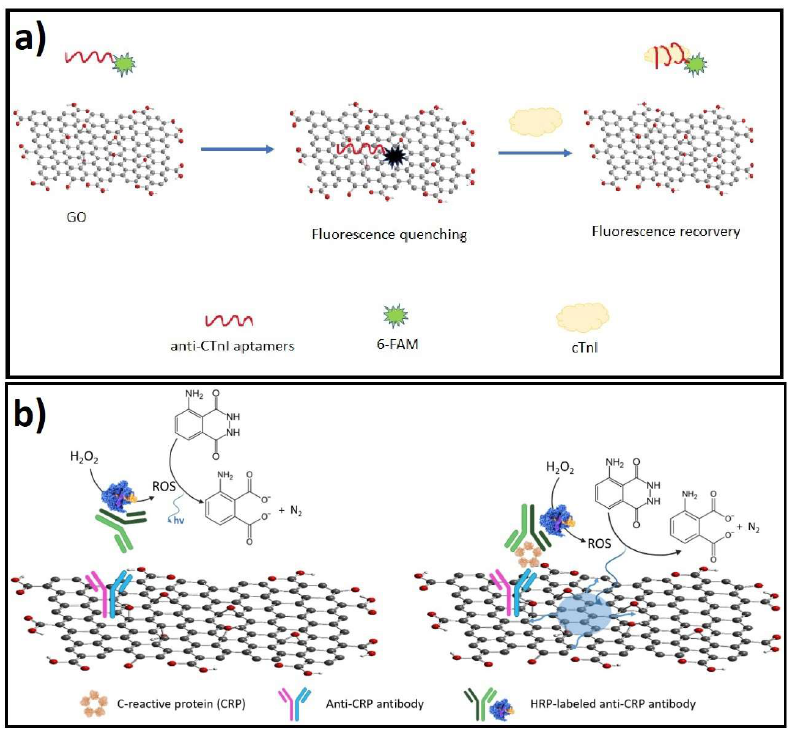
Figure 3. Optical Biosensors. ( a ) Fluorescence aptasensor based on a GO for fluorescence quenching and detection of cTnI. ( b ) Design and application of a CRET-type platform to detect CRP